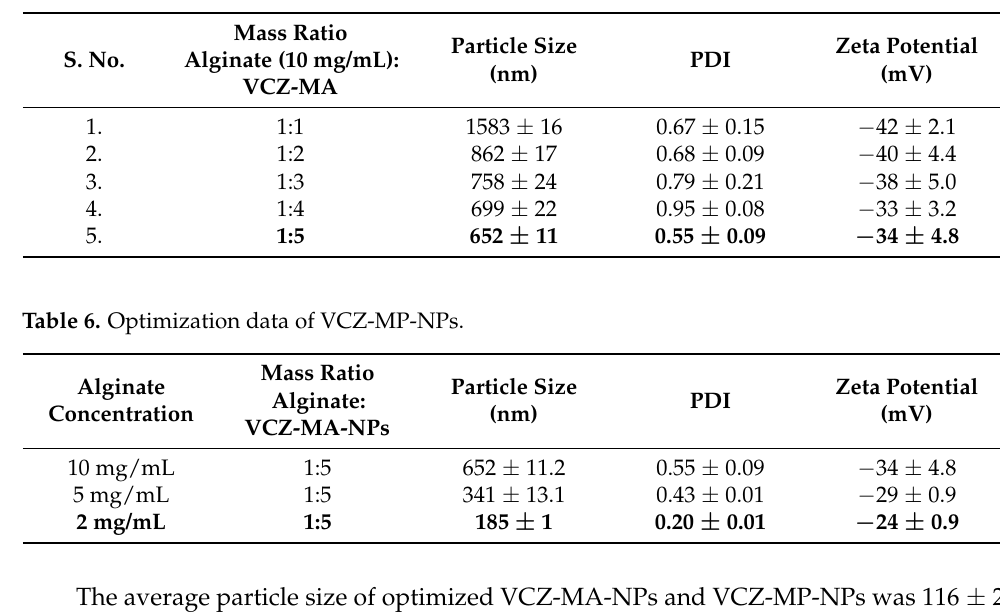
Table 5. Optimization of alginate to VCZ-MA-NPs mass ratio.